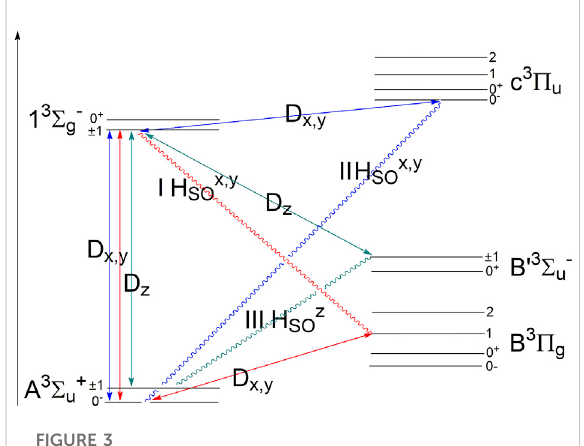
FIGURE 3 Scheme of intensity borrowing for the forbidden Σ − g → Σ + u transition.The fi rstandsecondmechanismsprovideperpendicular polarization, and the third one is responsible for the parallel polarization along the N – N